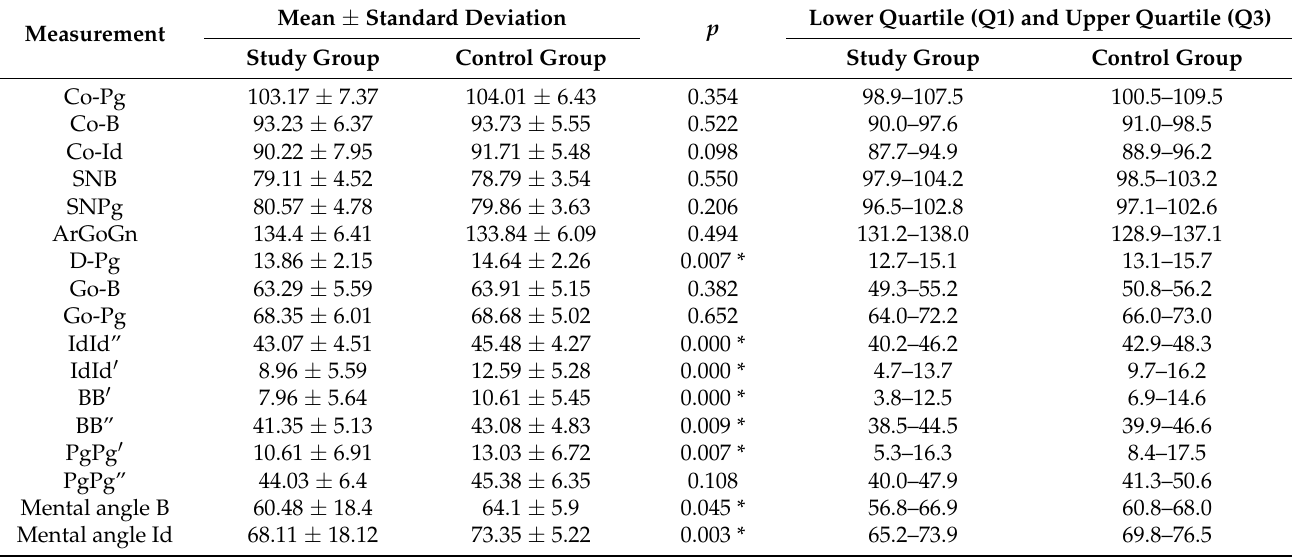
Table 5. Results of statistical analysis between the study and the control